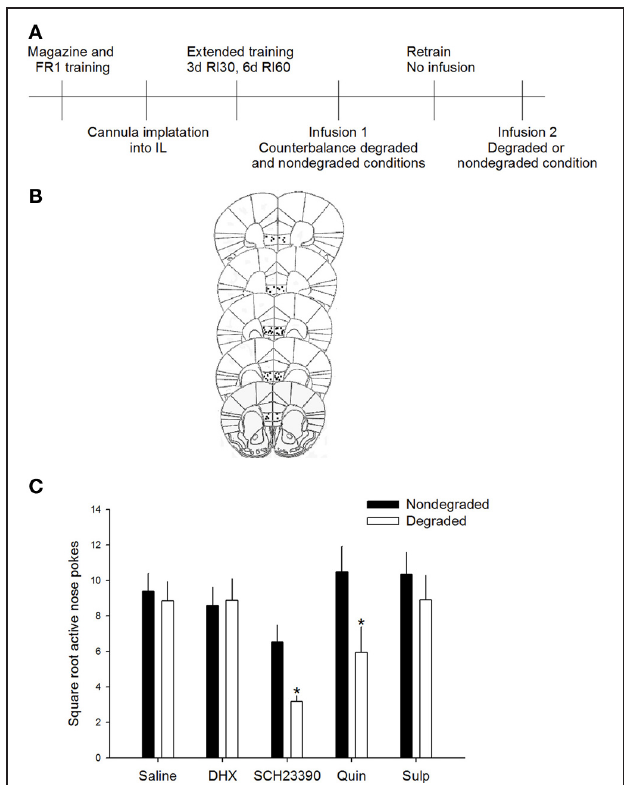
FIGURE 1 | D1 antagonism or D2 agonism restore goal-directed behavior. (A) Experimental timeline. Mice only received infusions of drugs during counterbalanced test sessions. One half of mice received the degraded session first while other mice received a non-degraded session first. (B) Only mice whose cannulae were placed within the IL were included in analyses. Images modified from Paxinos and Franklin (2001). (C) Inhibition of D1 signaling with SCH23390 or agonism of the D2 receptor with quinpirole in the IL resulted in reduced responding only during the degraded session, consistent with restoration of goal-directed behavior. Error bars ± SEM. ∗ p < 0 . 05.